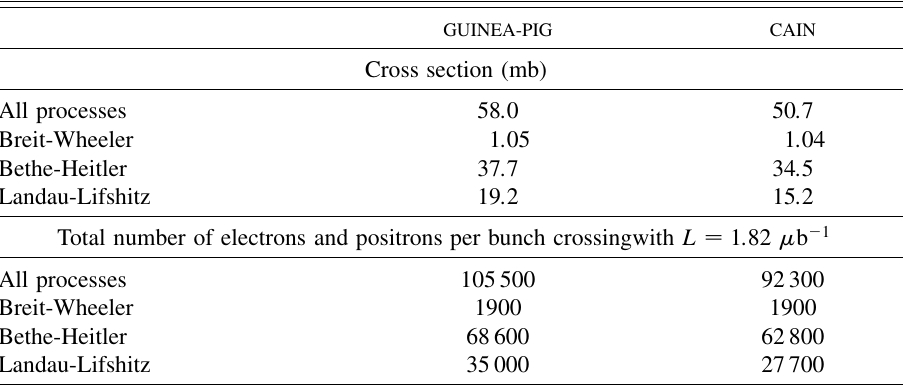
TABLE II. Number of particles per bunch crossing and (effective) cross sections for each IPC process in GUINEA-PIG and CAIN .